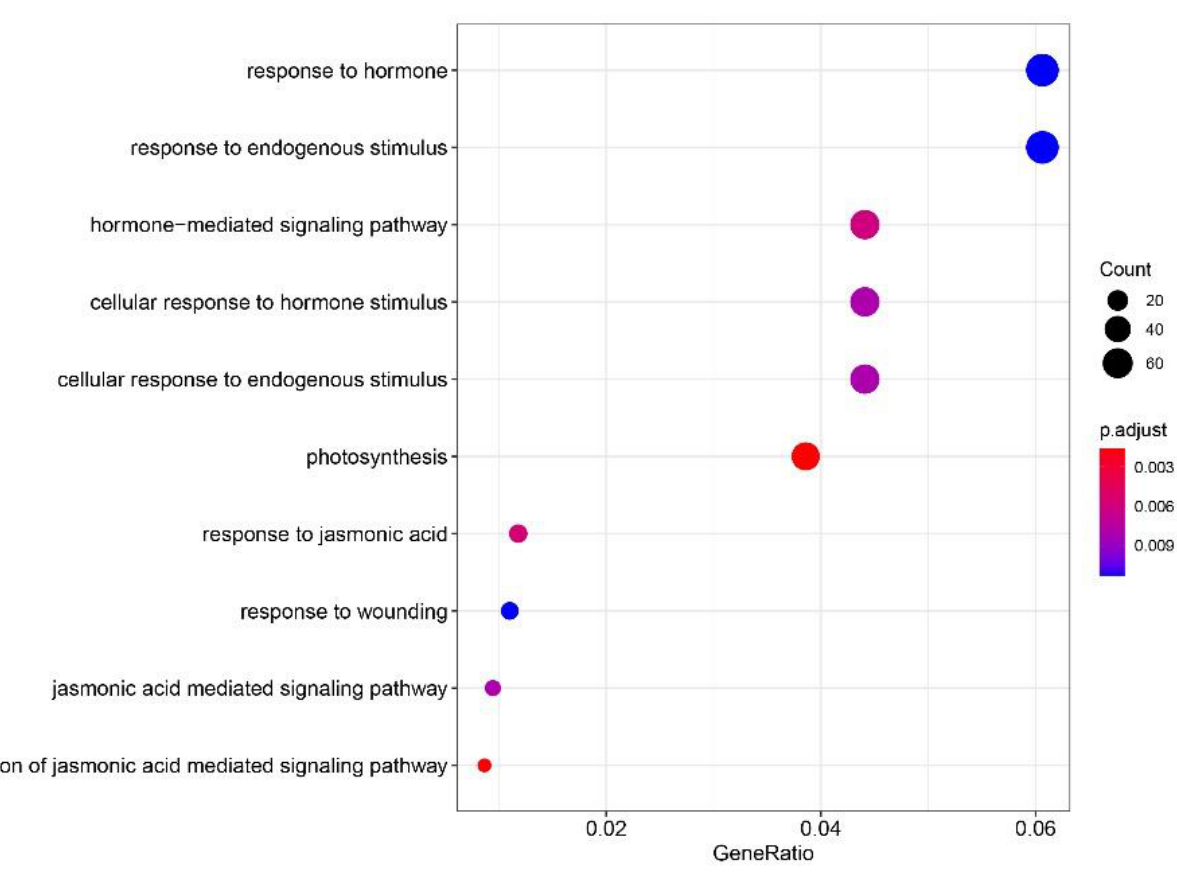
Figure 4. GO enrichment analysis of DEGs.